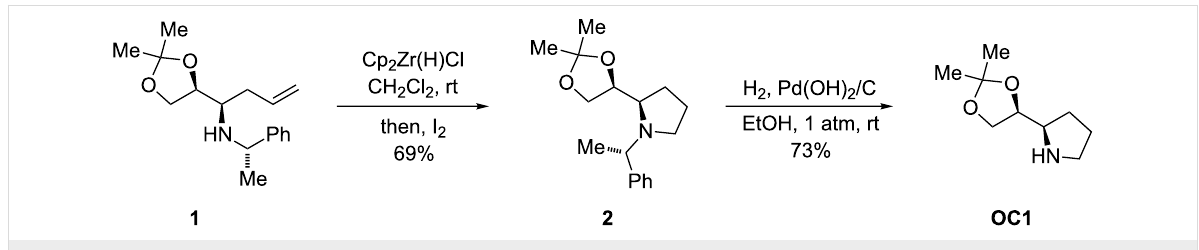
Scheme 1: Synthesis of the new organocatalyst OC1 .